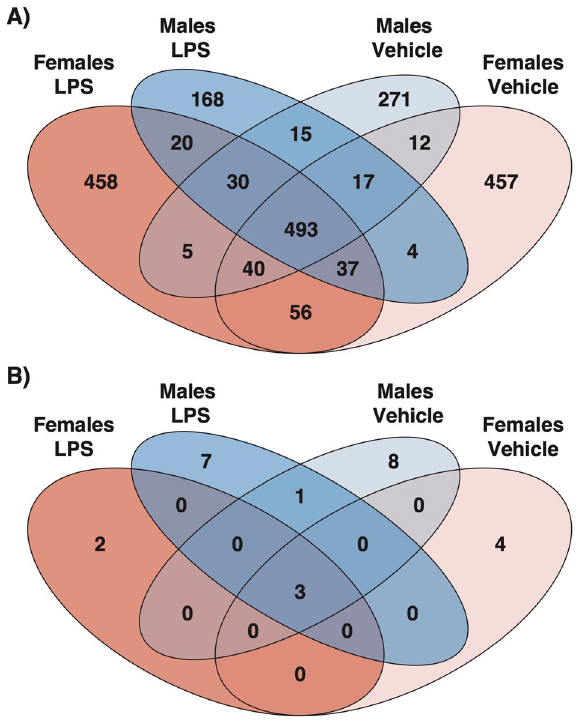
Figure 5. Venn Diagrams with ( A ) Number of significant eGenes by condition (lfsr < 0.05) on the autosomes, and ( B ) number of significant eGenes by condition (lfsr < 0.05) on the X